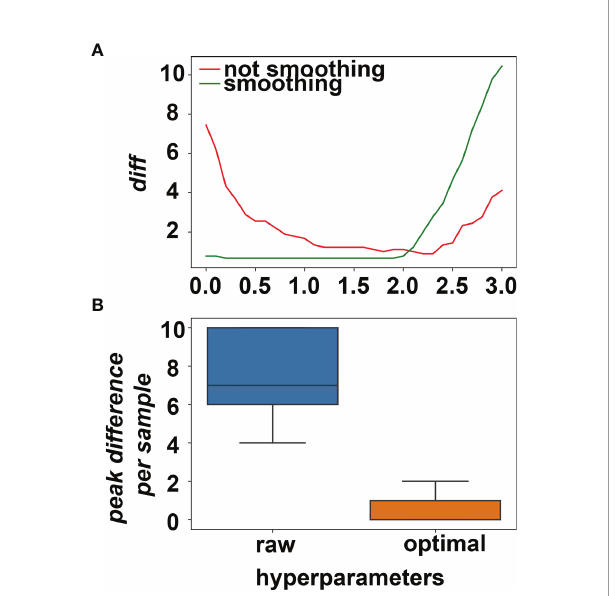
FIGURE 4 | (A) The average difference between NGS data and PCR data changes for different hyperparameters. The minimum of average difference was obtained when smoothing was applied and the peak threshold was set to (20% × average depth). (B) The peak differences between NGS and PCR for all the training samples before and after picking the optimal hyperparameters.